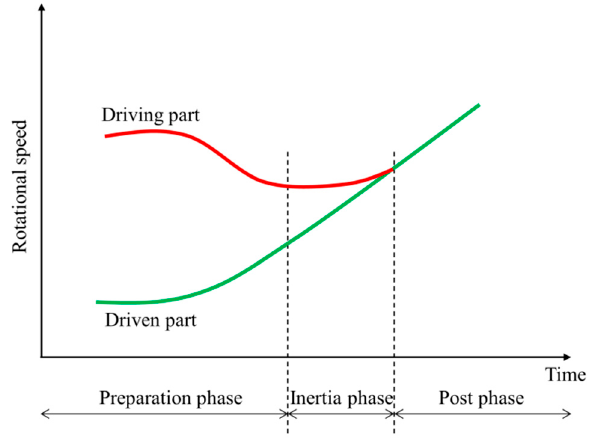
Figure 2. Process of clutch engagement.